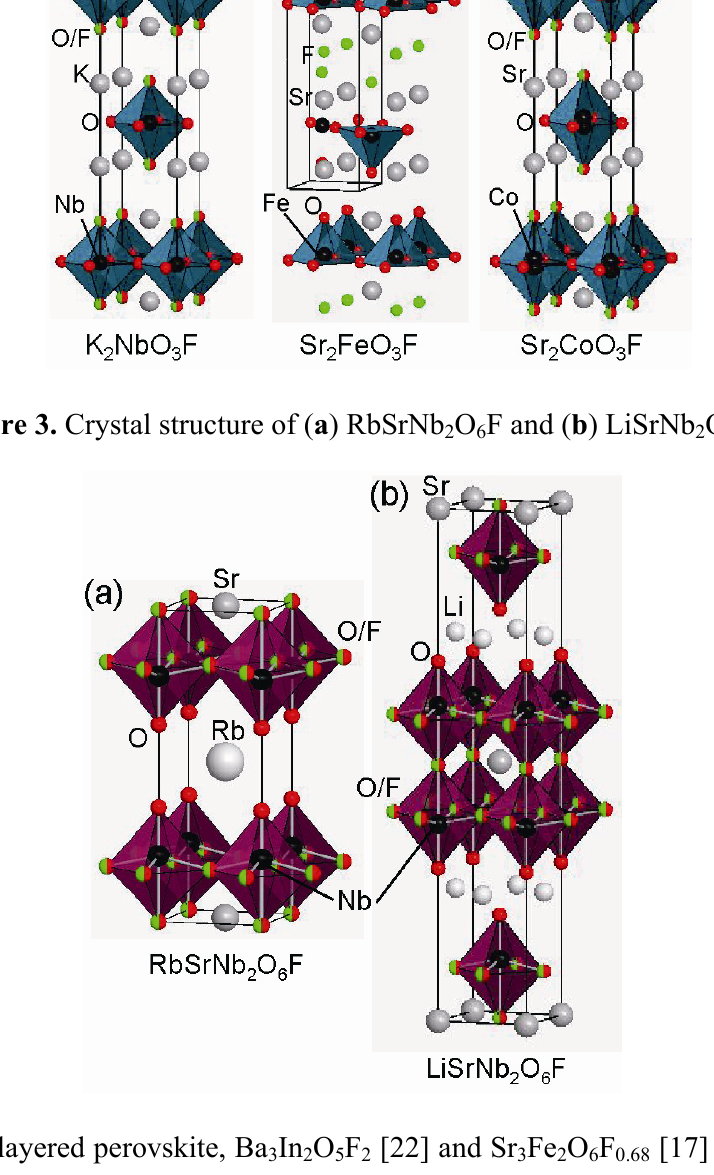
Figure 2. Crystal structure of ( a ) K represents the unit cell.